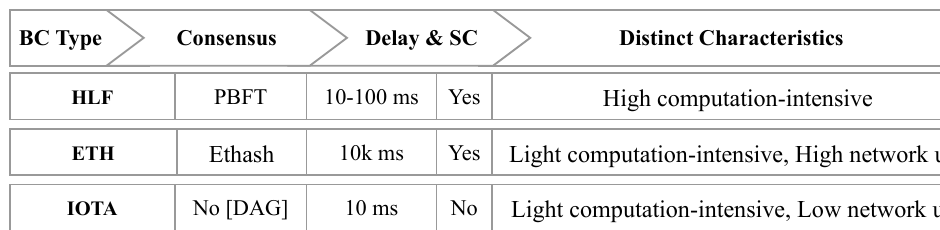
Figure 3. The comparative analysis of ETH, HLF, and IOTA